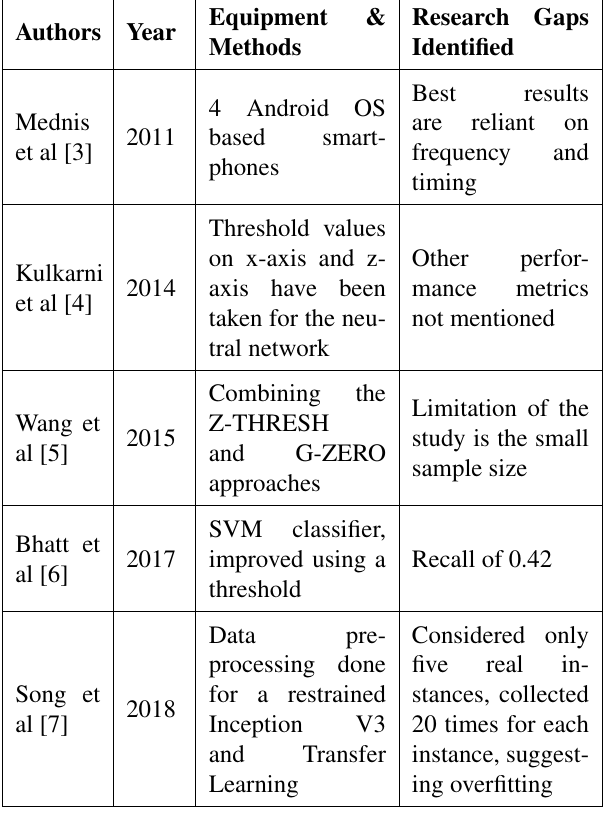
Table 1. Analysis of Literature Survey